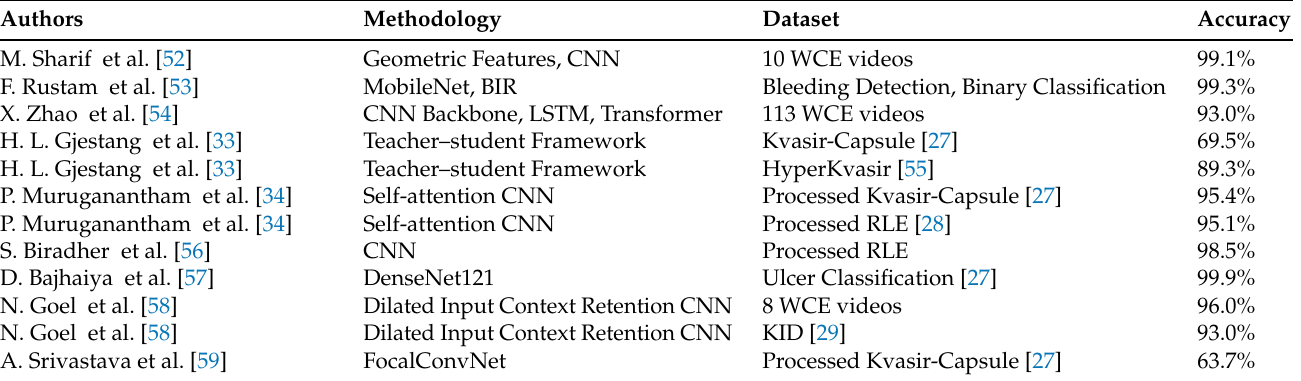
Table 2. Comparison of the classification results of this study and other